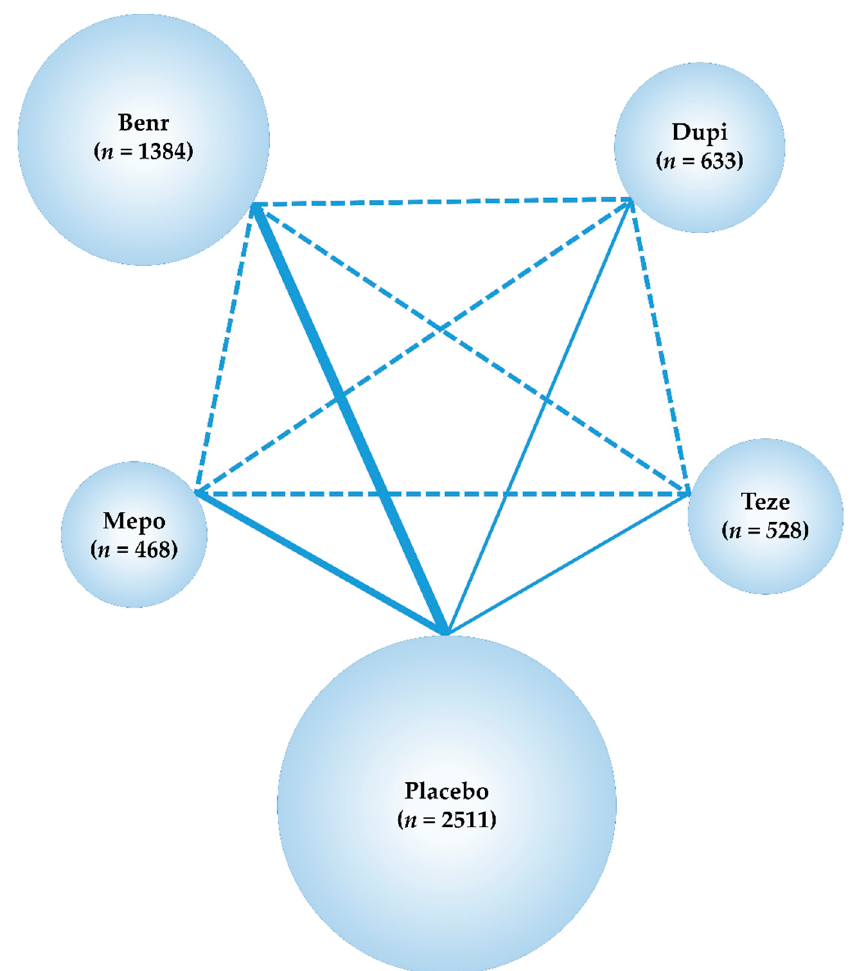
Figure 3. Network map of the five treatment arms tezepelumab, dupilumab, benralizumab, mepolizumab, and placebo. The RCTs included in the present network meta-analysis are indicated by solid lines, and the width of the solid line represents the number of included studies. Dashed lines indicate that there were no previous head-to-head RCTs and that indirect treatment comparisons can be attempted. n is the number of participants in each treatment arm. Teze, Tezepelumab; Dupi, dupi-